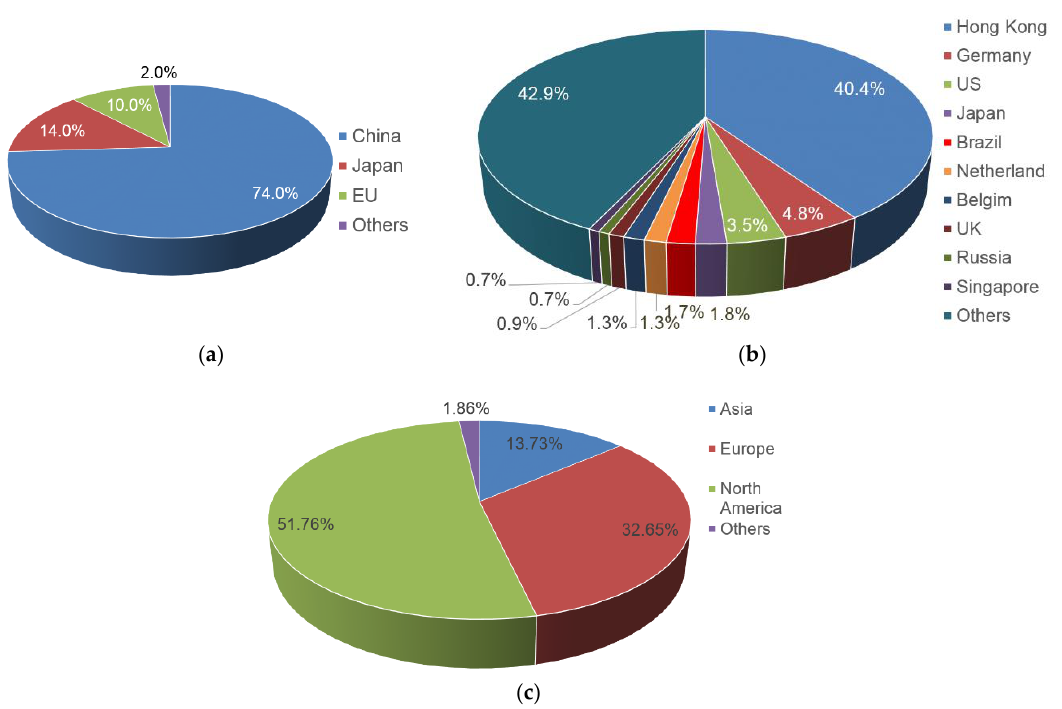
Figure 1. Consumer Ni/MH battery market shares for ( a ) Sources in 2013, ( b ) Exports from China in 2013, and ( c ) Exports from Japan in February 2014. Data originate from [2]. Table 1. European companies related to Ni/MH battery manufacturing included in this review, in order of their presence.